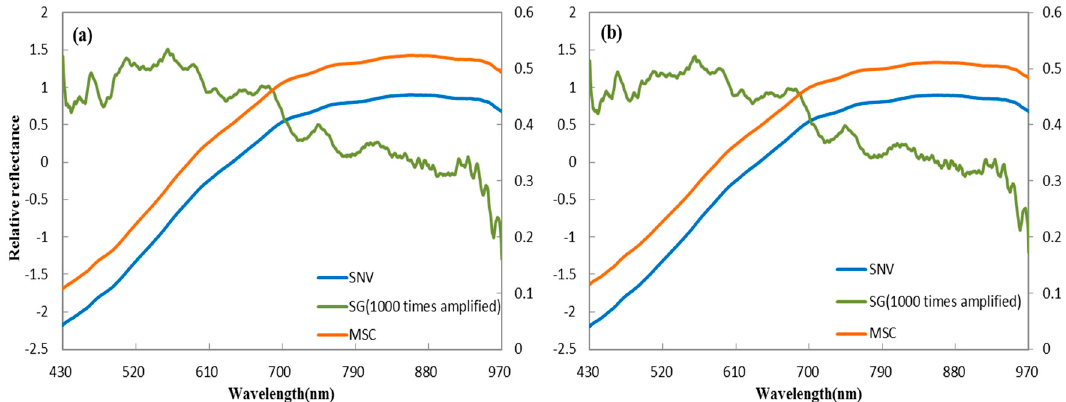
Figure 2. Average spectra preprocessed by standard normal variate (SNV), Savitzky-Golay (SG), and multiplicative scatter correction (MSC) methods; ( a ) ventral groove side; and, ( b ) reverse side.